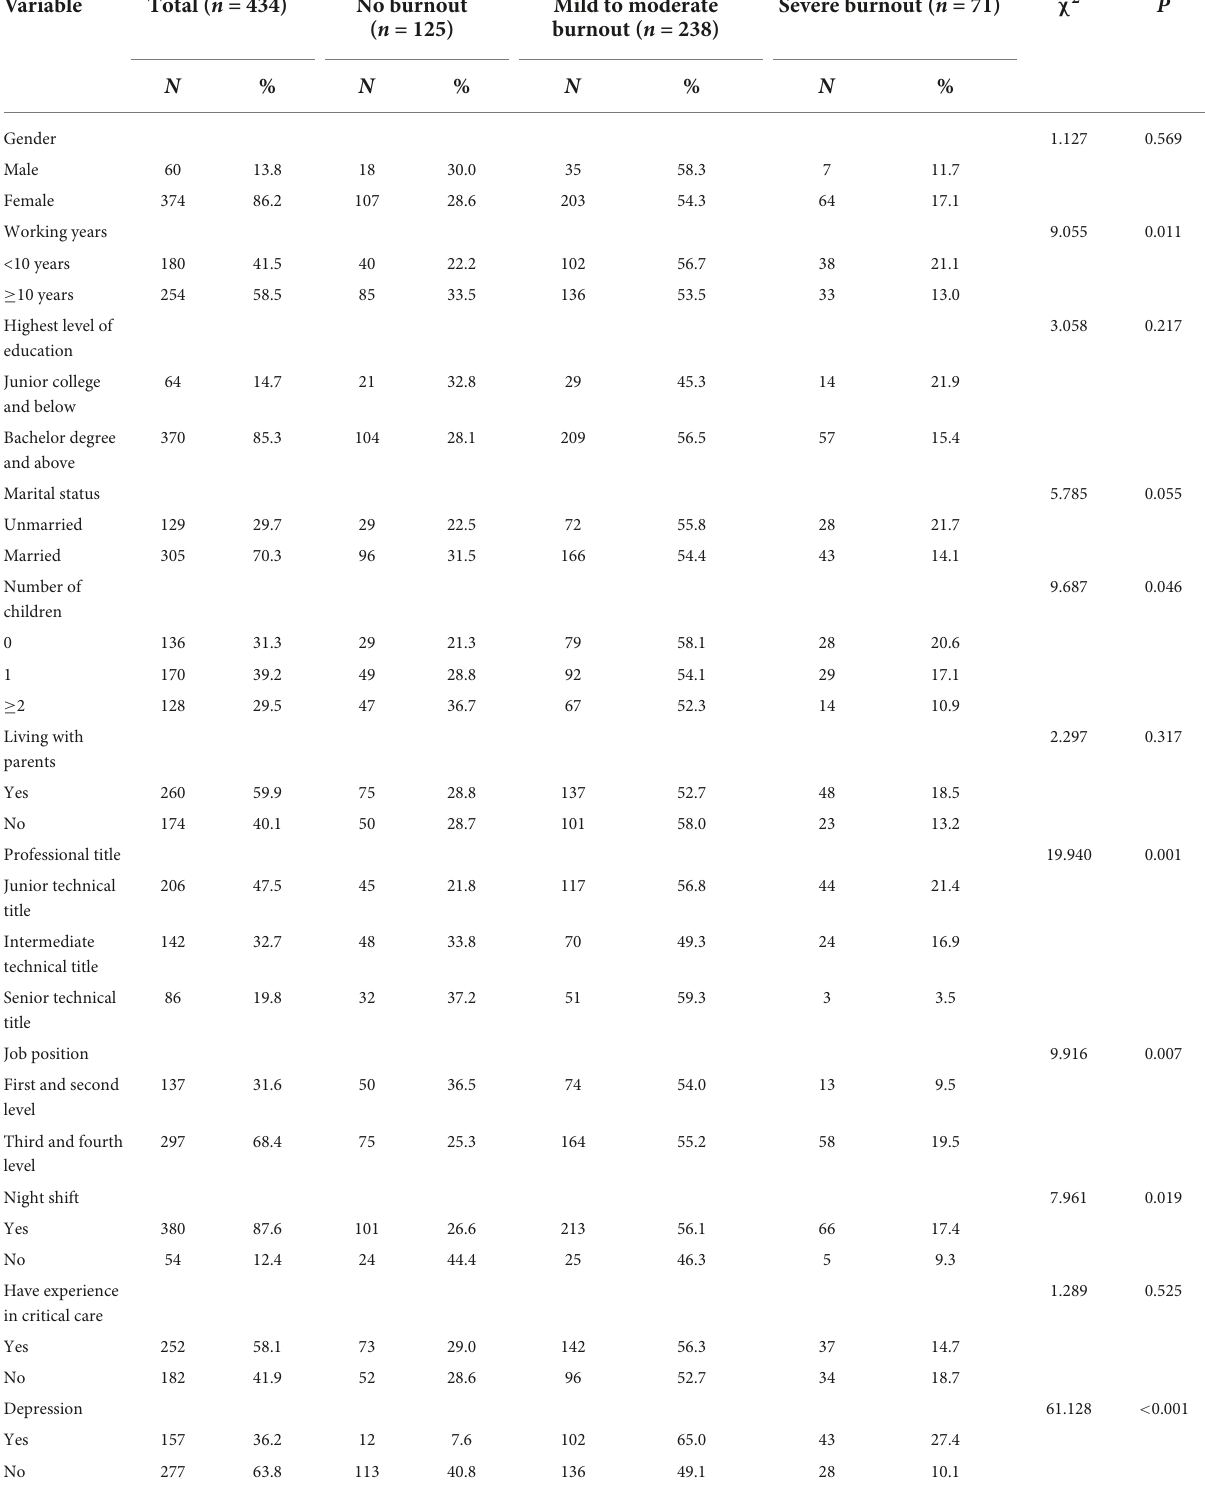
TABLE 1 Demographic characteristics and burnout among stay behind healthcare workers ( n =